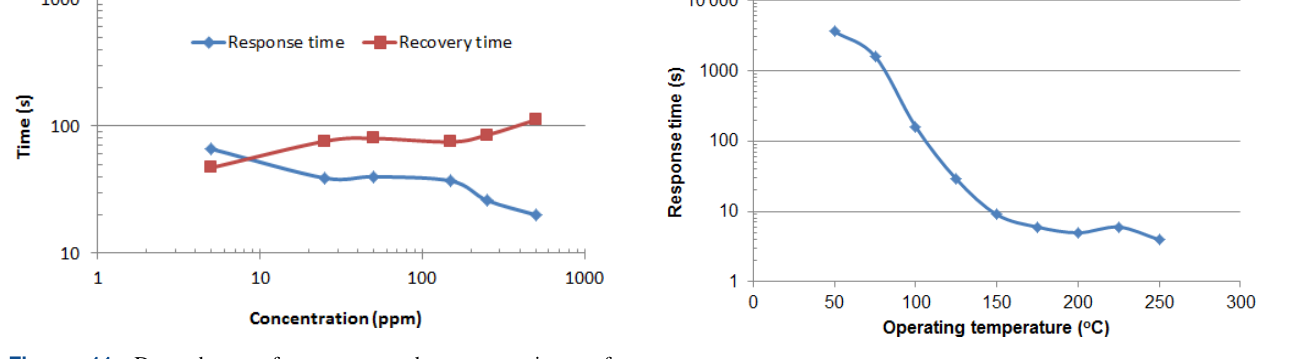
Figure 13. Dependence of the response time of MWCNTs/SnO 2 PG vapor sensor on operating temperature.